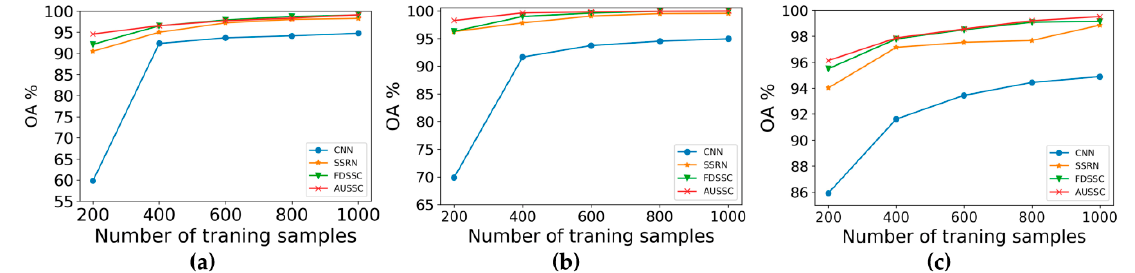
Figure 14. The overall accuracy (OA) of different methods for different numbers of training samples in three HSI data sets. ( a ) Indiana Pines (IP) data set; ( b ) Kennedy Space Center (KSC) data set; and ( c ) Salinas Scene (SS) data set.